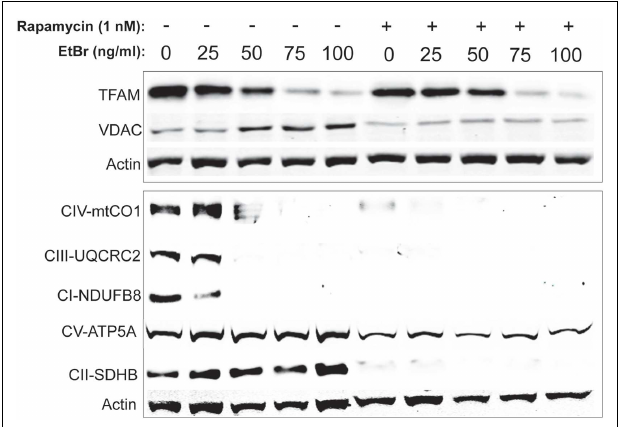
FIGURE 5 | Steady state levels of mitochondrial proteins following ethidium bromide exposure . Human fibroblast cell cultures grown in the presence or absence of 1nM rapamycin were exposed to increasing doses of ethidium bromide for a period of 7days. At this time, total cellular protein extracts were prepared and analyzed by immunoblot as described in Section “Materials and Methods” for a subset of mitochondrial resident proteins.The levels of beta-actin are presented as a control for equal protein loading.The immunoblot presented is a representative blot of a minimum of two measurements with similar results.